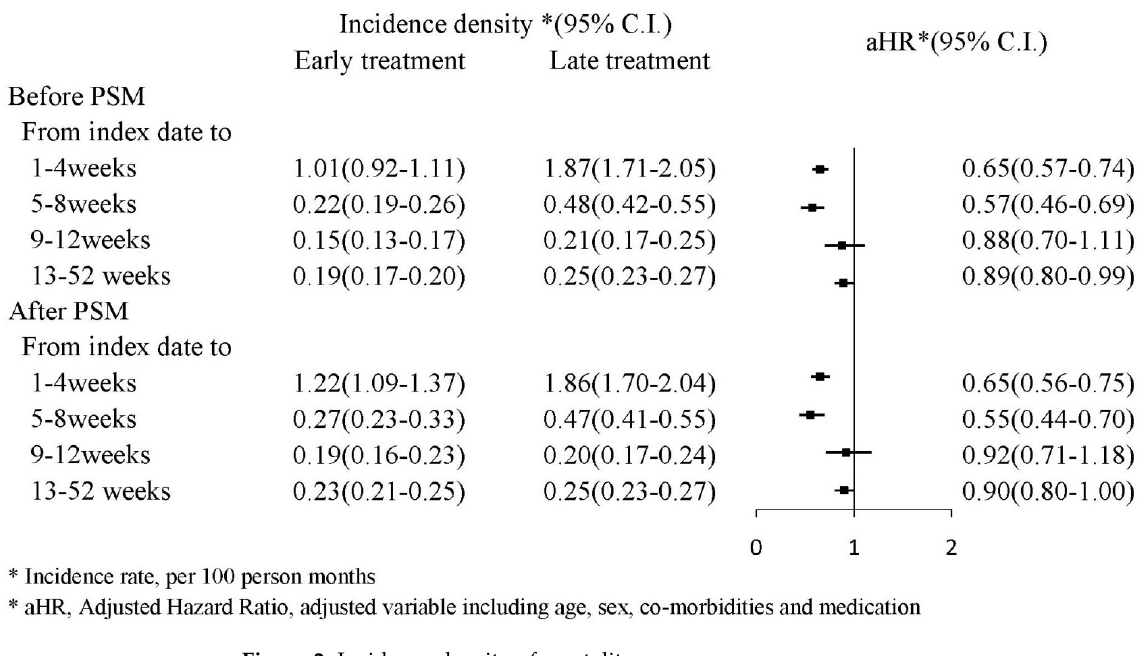
Figure 2. Incidence density of mortality.